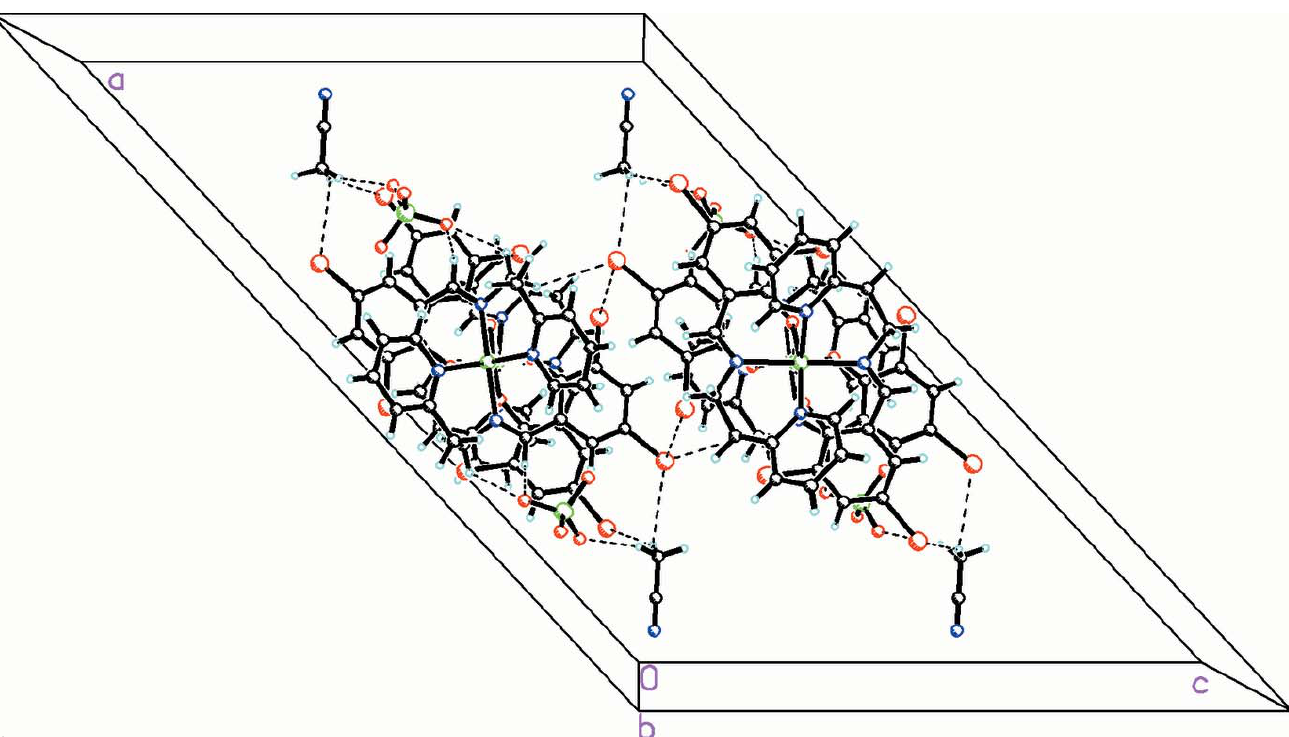
Figure 2 Packing diagram viewed along the b axis showing the extensive C—H (cid:2)(cid:2)(cid:2) O, C—H (cid:2)(cid:2)(cid:2) N, and C—H (cid:2)(cid:2)(cid:2) Br interactions (shown as dashed lines) linking the cations, anions, and solvent molecules into a complex three-dimensional